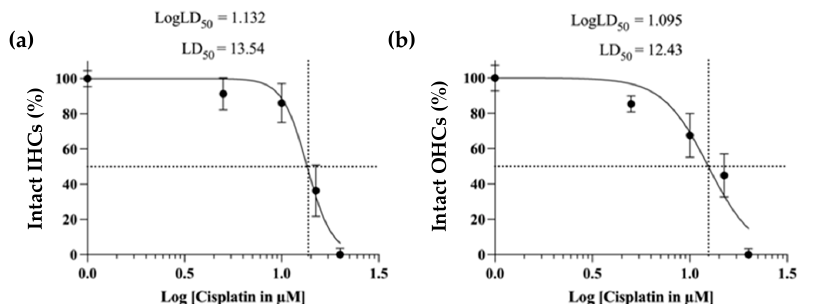
Figure 5. Dose effect of cisplatin as a function of the percentage of intact IHCs and OHCs. The cell survival rate was determined based on the percentage of intact IHCs and OHCs. For this purpose, the intact HCs (n = 4 each) were quantified lengthwise in the entire OC (per 100 µm) in specimens exposed to 5 µM, 10 µM, 15 µM, and 20 µM cisplatin. The control group (n = 3) was cultured in a standard medium for 24 h. Shown is the percentage of intact HCs in the entire OC. The values were normalized, and the cisplatin concentrations (abscissa) were presented on a logarithmic scale. ( a ) Dose–response curve for the intact IHCs. ( b ) Dose–response curve for the intact OHCs. The data represent four independent experiments and are reported as mean ± SEM. 2.2.3. Cromolyn Inhibits the Cisplatin-Induced Degranulation of Cochlear Mast Cells The cochlear explants were exposed for 24 h to 15 µM cisplatin and various concentrations of cromolyn. Statistical analysis indicated that 5, 10, and 25 µM cromolyn efficiently blocked the MC degranulation process in the cochlea (Figure 6a). Cromolyn used at 50 µM was no longer effective in blocking cisplatin-induced MC degranulation. Representative images of the MCs in the LW of the respective treatment groups are shown in Figure 6b–g. The control group (Figure 6b) and the group pretreated with 5 µM, 10 µM, and 25 µM cromolyn (Figure 6d–f) contained intact MCs with cytoplasmic granules labeled by avidin. The cisplatin-exposed tissues (Figure 6c) and the group pretreated with 50 µM cromolyn and exposed to cisplatin (Figure 6g) contained avidin-positive granules scattered into the extracellular space.